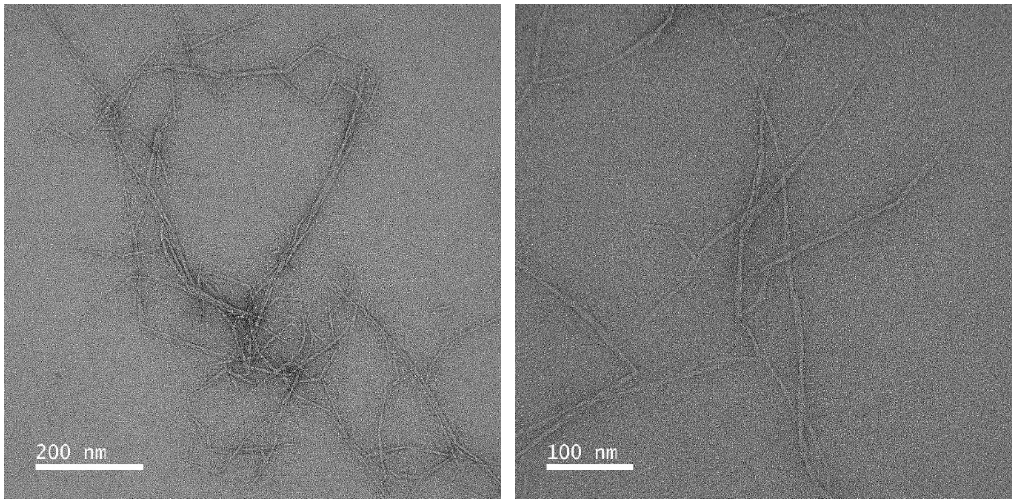
Figure 6. TEM images of TEMPO-oxidized CNFs from PMBFs and softwood fibers.